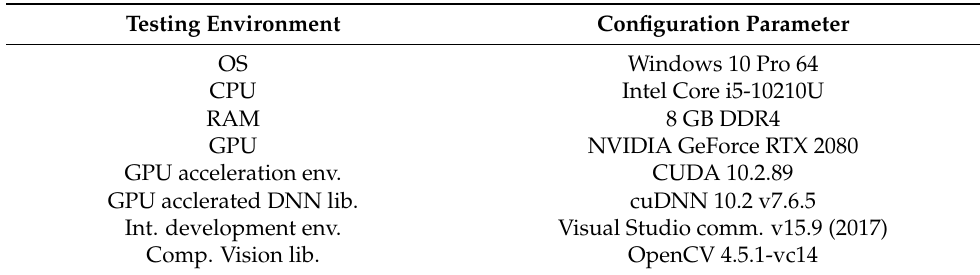
Table 2. Local computing resources and DNN environments.